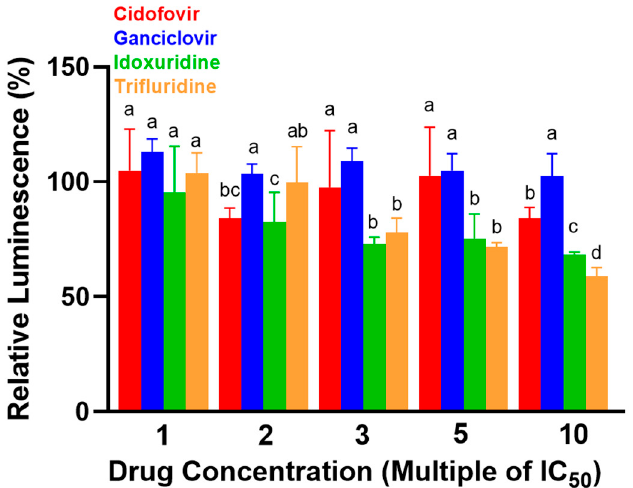
Figure 3. In-vitro comparison of nucleoside analogue antiviral agent cytotoxicity to Madin–Darby Bovine Kidney (MDBK) cells via CellTiter-Glo ® assay. Relative luminescence (RL) is correlated with cellular ATP concentration; lower relative luminescence therefore indicates greater cytotoxicity. Lowercase letter labels “a–d” refer to statistical comparisons of RL amongst antiviral compounds— columns connected by the same letter labels are not significantly different ( p > 0.05).